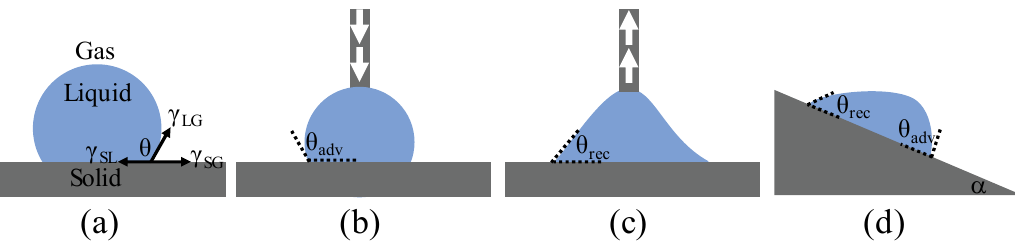
Figure 1. Schematics of contact angle types. The grey region represents the solid surface and the blue color represents the liquid on top. ( a ) Static contact angle θ and interfacial surface tension γ according to Young’s Equation. ( b ) and ( c ) represent a method to measure the advancing and receding contact angle. The arrow represents the direction of external pressure to dispense water onto or retreat water from the solid surface through a dispensing needle. ( d ) Inclination angle α, advancing angle θ adv , and receding angle θ rec .